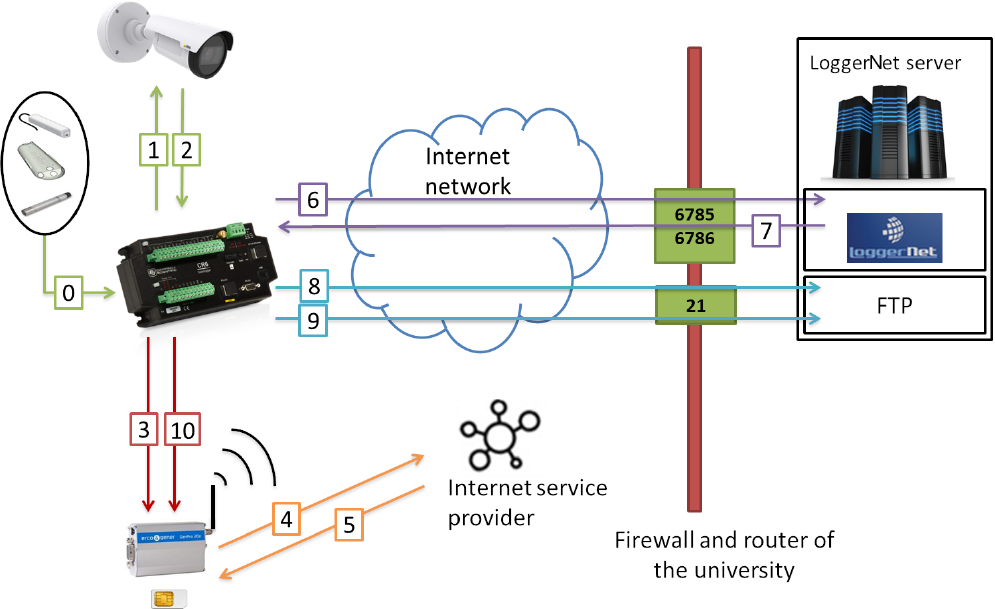
Figure 7. Diagram of the data collection and data transfer to the remote FTP server. (0) The data logger continuously retrieves data from the instruments integrated into RIPLE and stores the results in a table. (1) The data logger supplies power to the control camera for a few minutes, which automatically takes an image when it starts up. (2) The camera, configured as an FTP client, places the image on the data logger, which includes an FTP server. (3) The data logger supplies power to the GPRS modem. (4) The modem queries the Internet service provider to obtain a private IP address. (5) The data logger is then connected to the 2.5G, 3G or 4G network. (6) The data logger contacts the LoggerNet server via port 6786. (7) The LoggerNet software running on the LoggerNet server recognizes the data logger with its PakBus number and the connection is established. It is now possible for the manager of the platform to communicate remotely with the data logger. (8) The data logger sends its data tables to the FTP server of the laboratory (FTPClient instruction). (9) The data logger transmits the control image to the FTP server of the laboratory (FTPClient instruction). (10) The data logger switches off the modem after a few hours. (11) A web page created under Shiny (R package) is updated after each new data